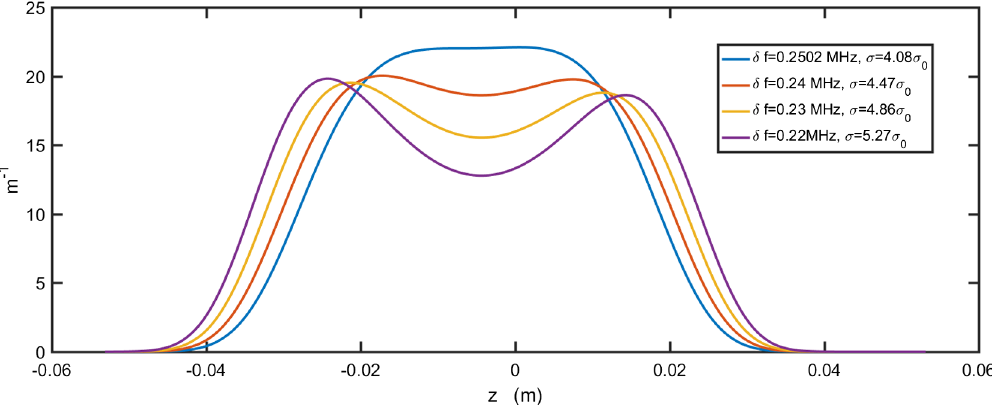
− 3 f 0 . 2502 ; 0 . 24 ; 1 ¼ ð r 0